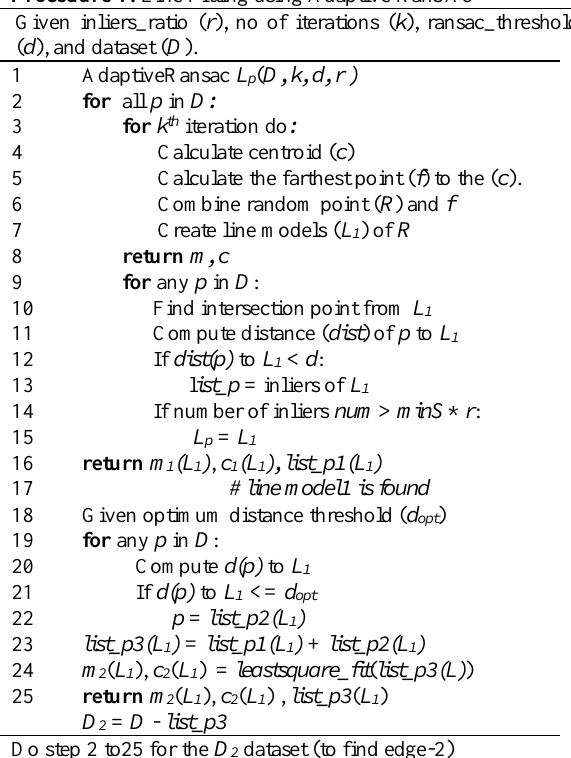
Figure 5. The centroid (blue) and corner points (red) The RanSAC parameters used in this study are minimum sample size ( minS ), distance to the model threshold ( d ), inlier ratio ( r ), and number of iterations ( k ). To initialize a line, two points are chosen from the given samples s to define a line model. Once the line model is created, the distance of each point to the respective line model is calculated. The final fit is obtained by fitting these inliers to the line model in the sense of least squares. For each edge, we use 100 iterations to find the potential line. The line model that exceeds the predefined r and has most inliers will be selected. The RanSAC parameters are tuned based on the expected requirements and input data specifications. In a normal case, for a point cloud with 50 cm spacing, we use an inliers ratio of 0.3 and a 0.6 meter model threshold distance. Procedure 1: Line Fitting using Adaptive